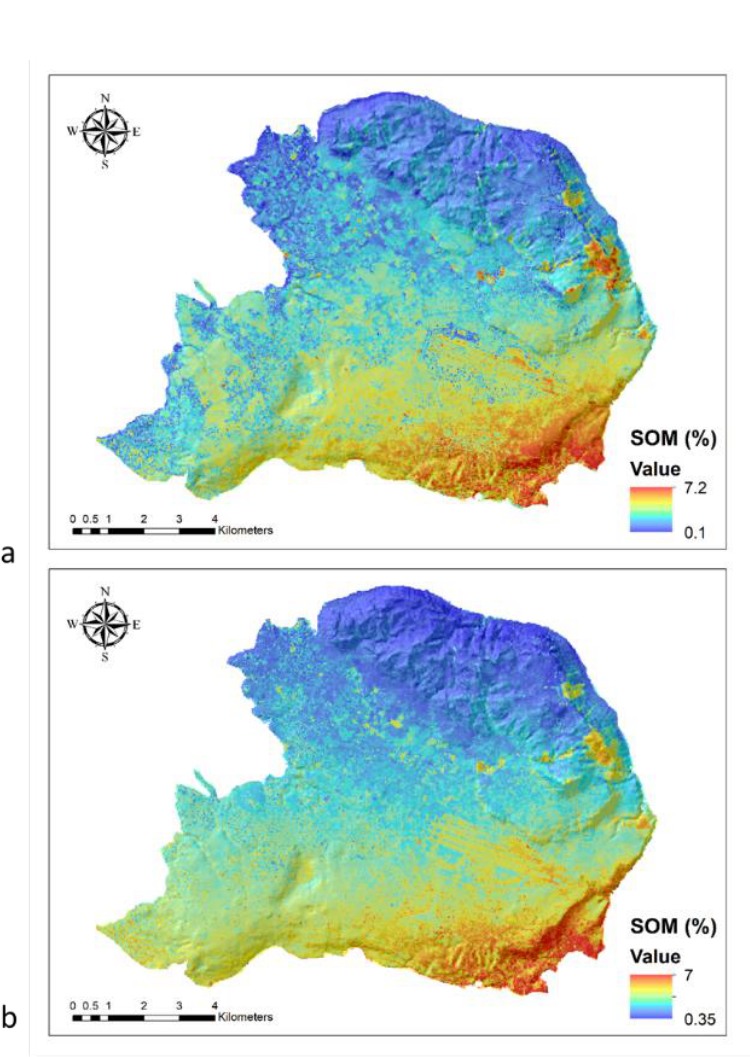
Figure 7. Spatial distribution of SOM as estimated from the integrated use of ANN and Landsat 8 ( a ) and Sentinel-2 ( b ) imageries.